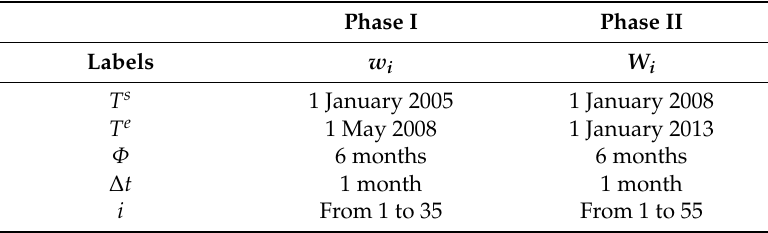
Table 2. Time window